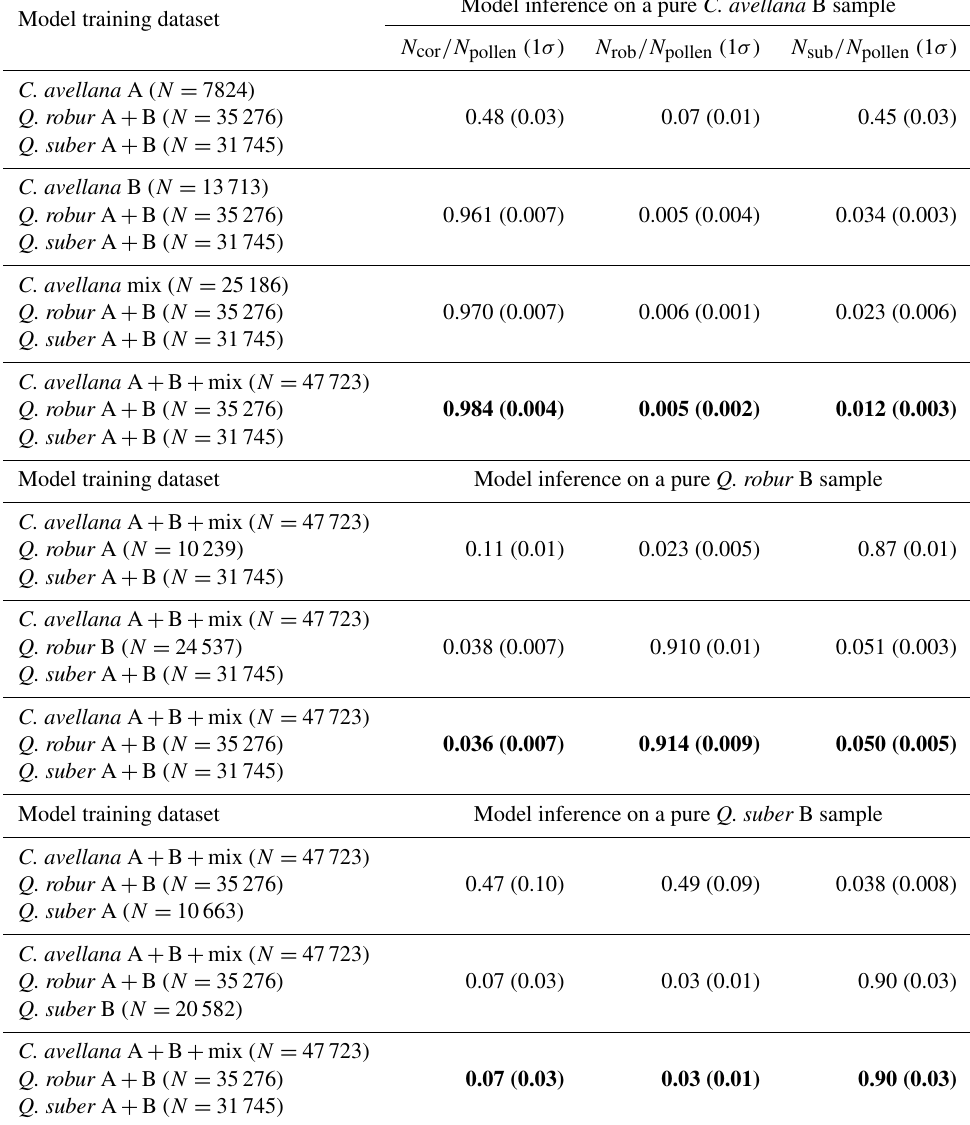
Table 3. Pollen experiment results. The accuracies are indicated as the average of the N replicates ( C. avellana N = 5, Q. robur N = 3, and Q. suber N = 10). In parentheses, the standard deviation of the replicates are given. Bold font refers to the cases in which the most general training datasets are